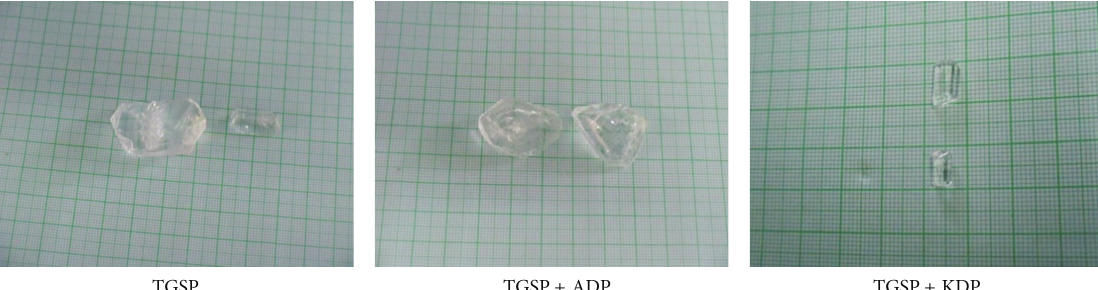
Figure 1: Grown crystals of pure and ADP-, KDP- (0.2mol) doped TGSP.